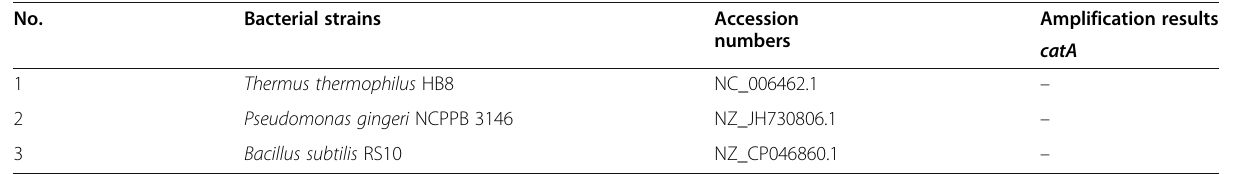
Table 13 In silico PCR result of primer pair catAf/catAr with known bacterial strains without (negative control) catechol 1,2- dioxygenase (C12O) gene No.